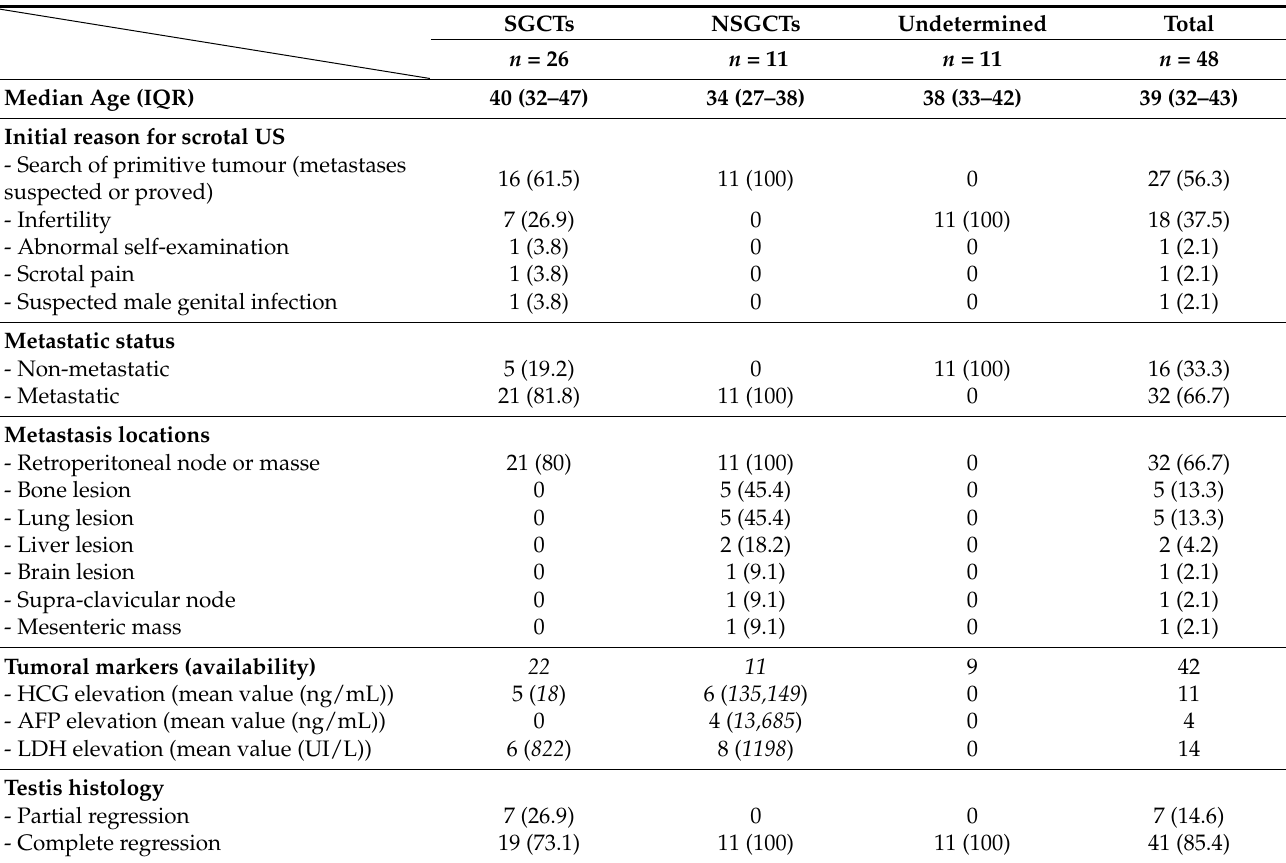
Table 1. Demographic, clinical, and biological